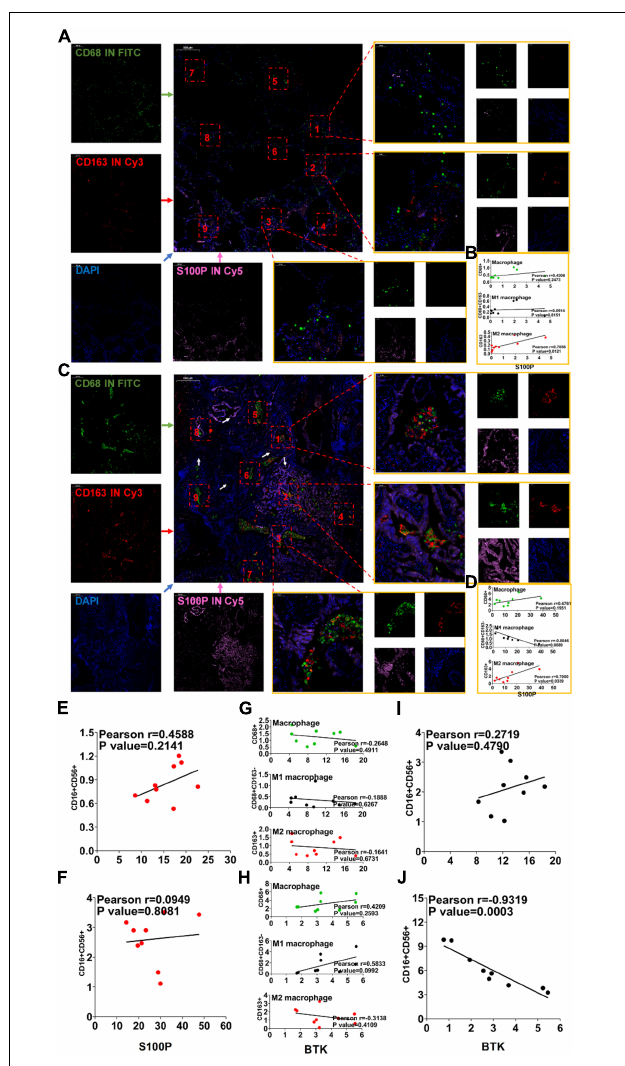
FIGURE 9 | Immunofluorescence verification of IRG expression and TICs related to prognosis. (A) Immunofluorescence of S100P and macrophages in paracancerous tissues. (B) Correlation map of S100P and macrophage expression in paracancerous tissues. (C) Immunofluorescence of S100P and macrophages in cancer tissues. (D) Correlation map of S100P and macrophage expression in cancer tissue. (E) Correlation map of expression of S100P and NK cells in paracancerous tissues. (F) Correlation map of expression of S100P and NK cells in cancer tissues. (G) Correlation map of BTK and macrophage expression in paracancerous tissues. (H) Correlation map of BTK and macrophage expression in cancer tissue. (I) Correlation map of expression of BTK and NK cells in paracancerous tissues. (J) Correlation map of expression of BTK and NK cells in cancer